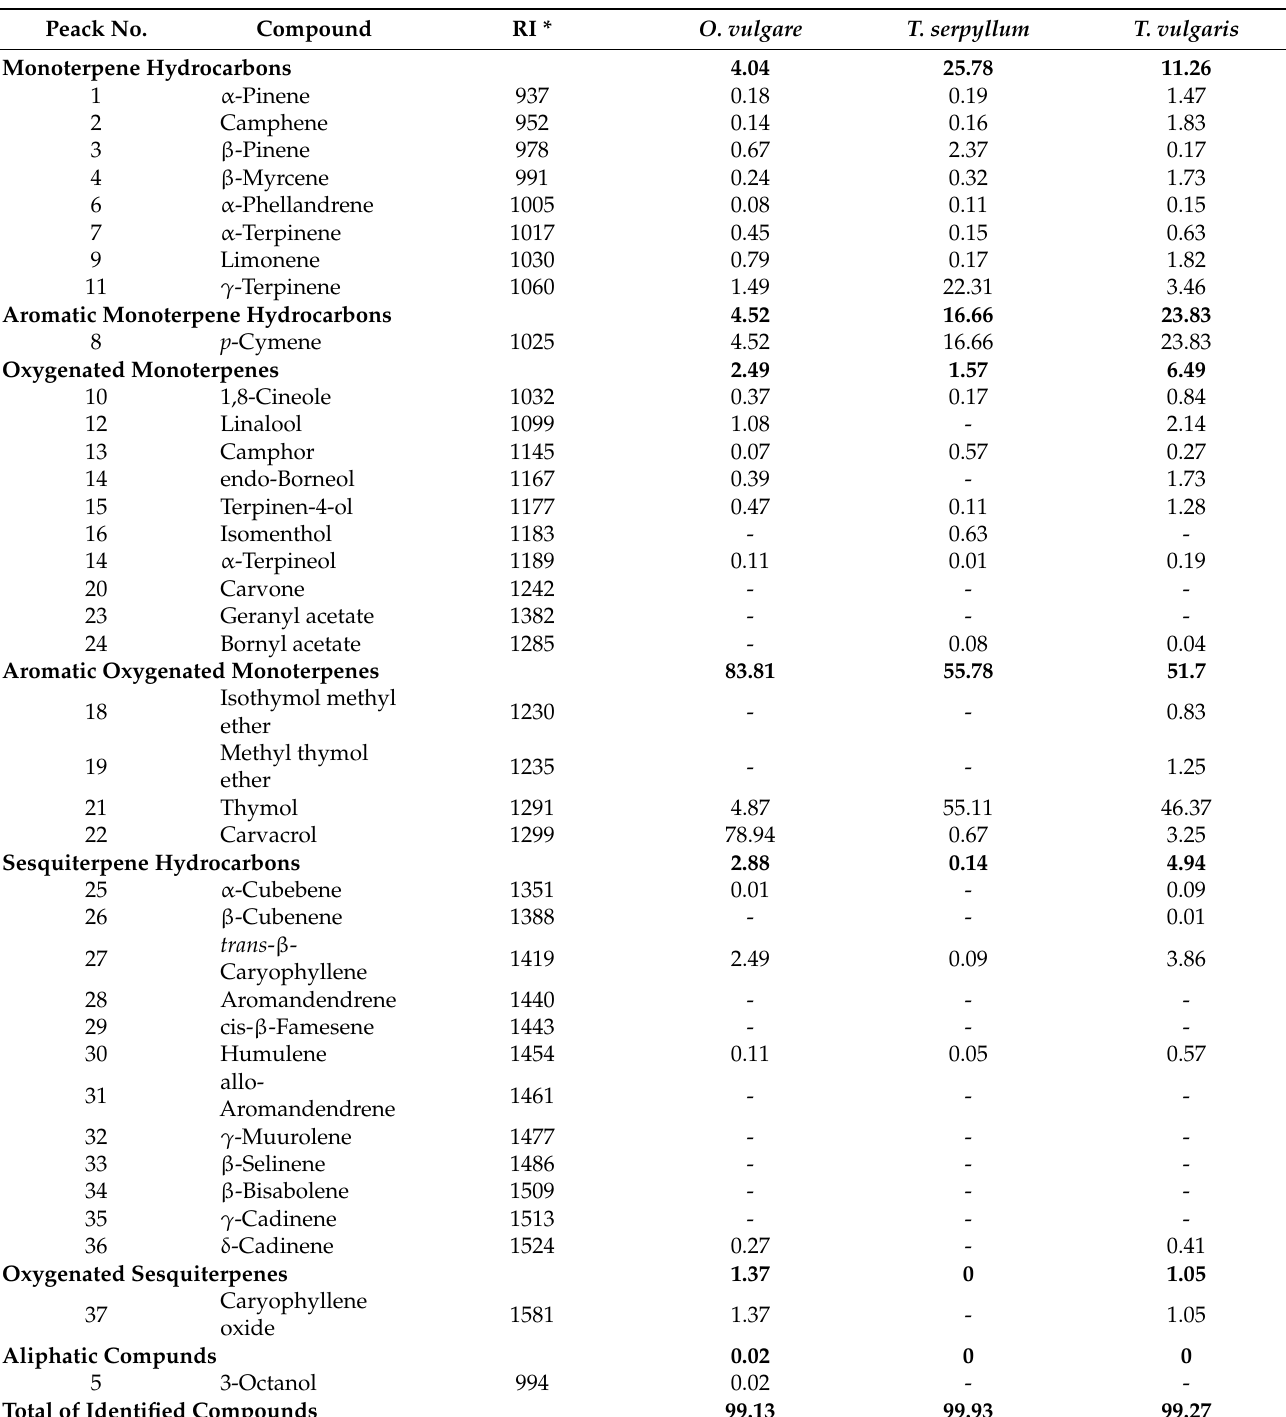
Table 1. Chemical composition of evaluated